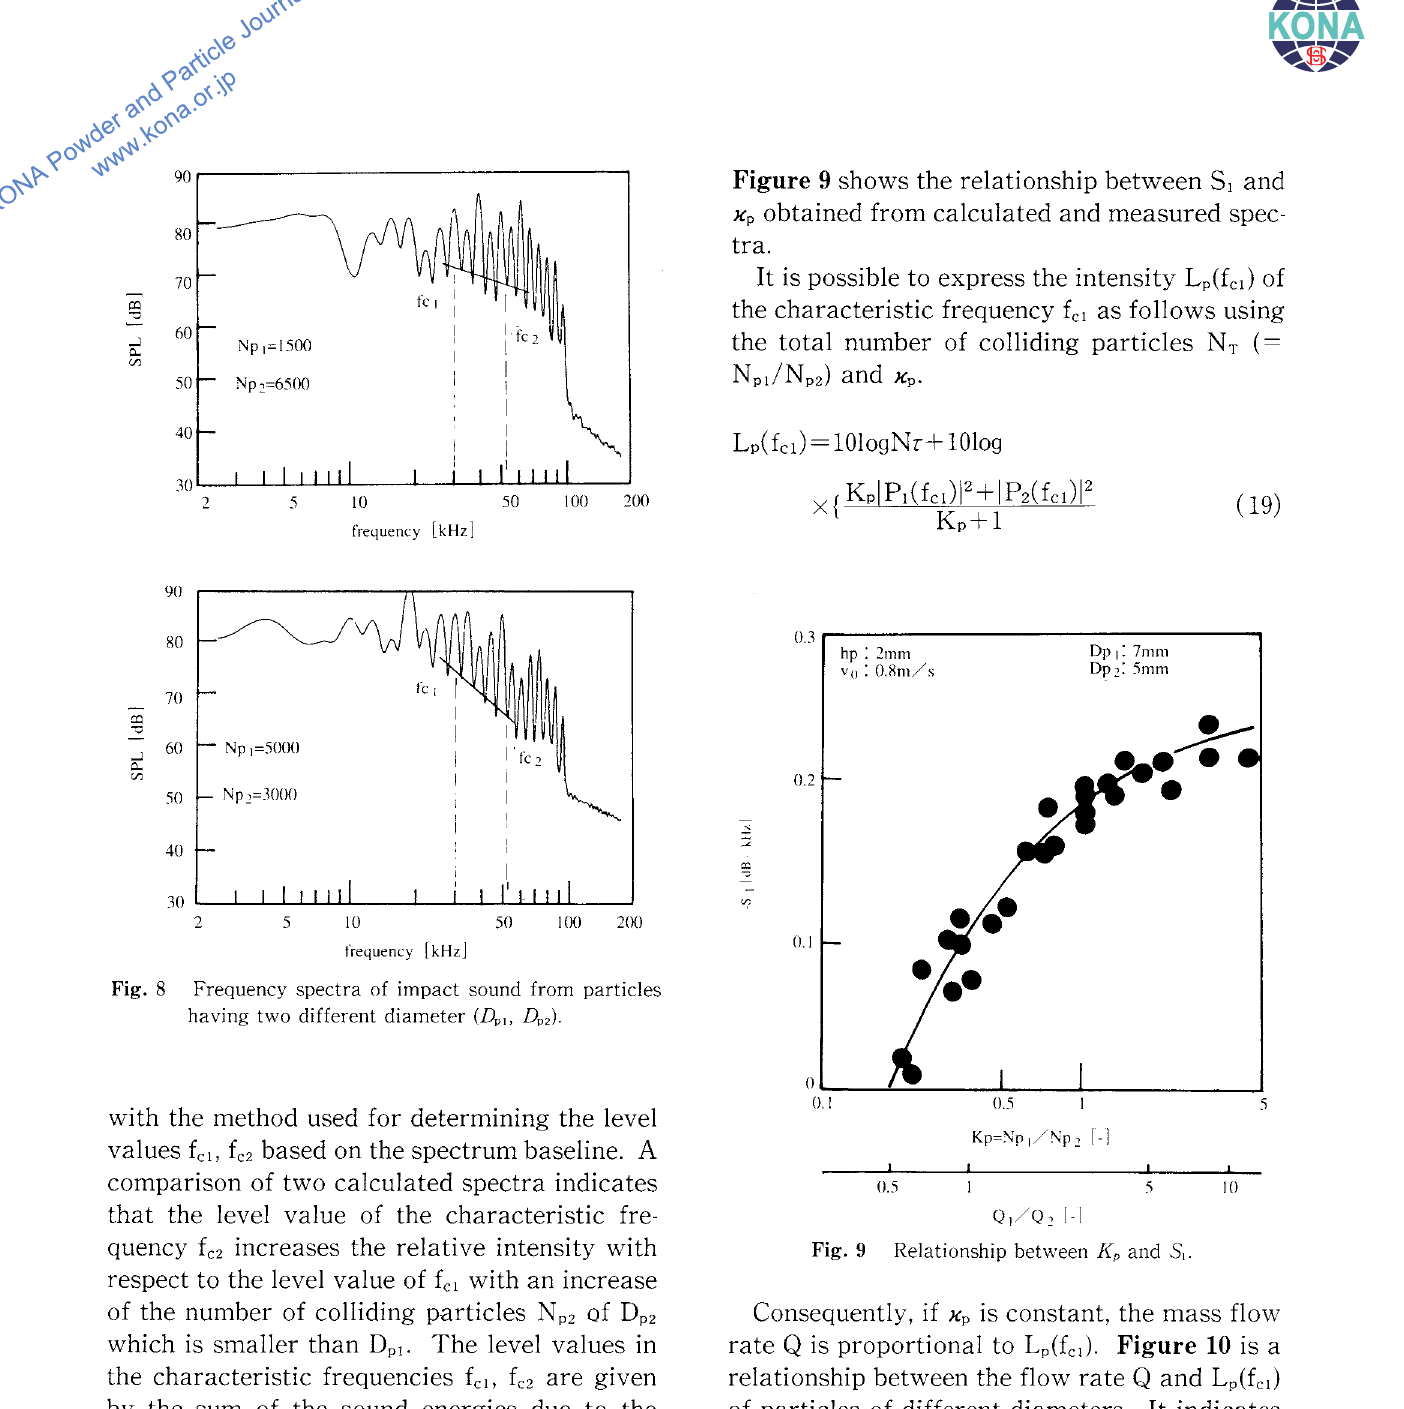
a linear relationship with a gradient of 10